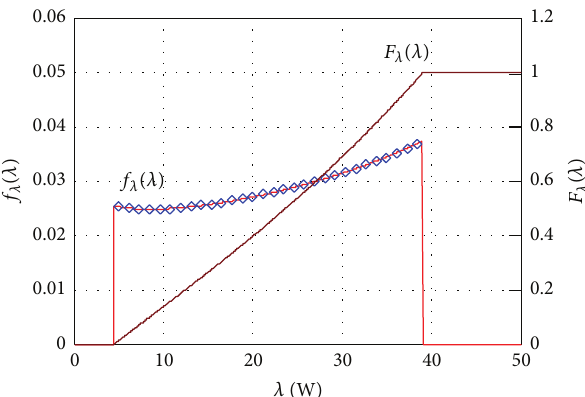
Figure 5: pdf and CDF of the maximum power obtained by the analytical method (curves) and pdf obtained by the Monte Carlo method of 10 7 simulation trials (scattered dots).